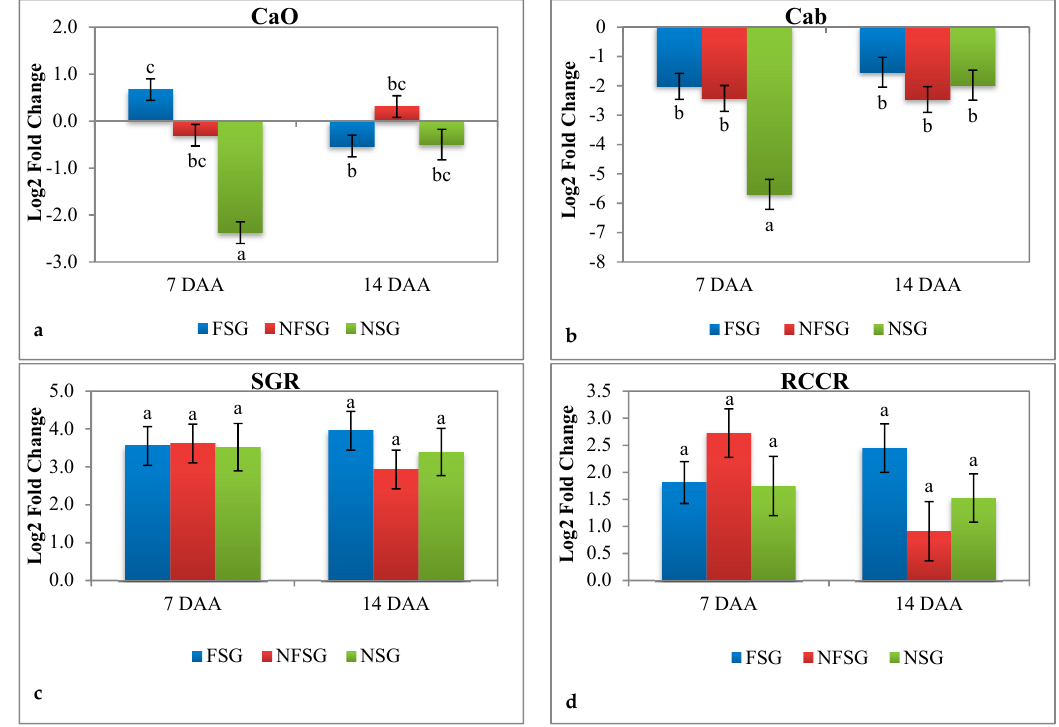
Figure 9. Fold change in the relative abundance of the CaO, Cab, SGR, and RCCR gene transcripts among functional stay-green (FSG), non-functional stay-green (NFSG), and non-stay-green (NSG) genotypes under terminal heat stress. FSG: functional stay-green (Nepal-38), NFSG: non-functional stay-green (SG-30), and NSG: non-stay-green (Sonalika). ( a ) Expression pattern of CaO; ( b ) expression pattern of Cab; ( c ) expression pattern of SGR; and ( d ) expression pattern of RCCR. Bar represents the least square mean of the log2 fold change using three biological and three technical replicates. The error bars refer to the standard errors and the different lowercase letters represent significant difference among the genotypes at p < 0.05.